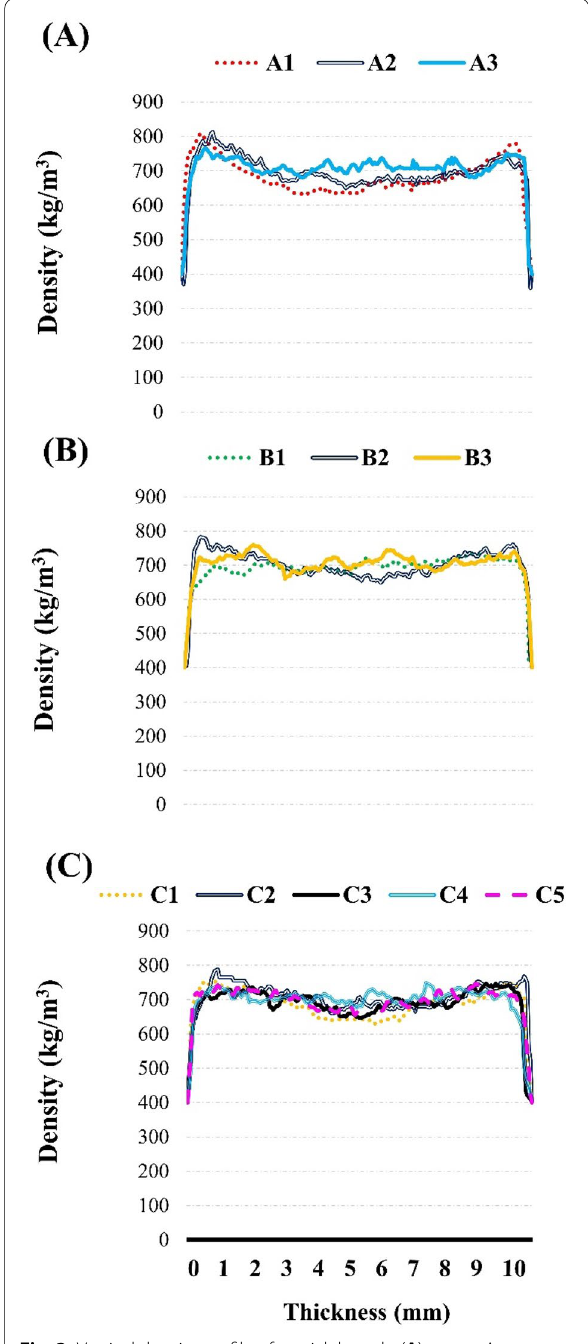
Fig. 3 Vertical density profile of particleboards, ( A ): group A (TOCS-based), ( B ): group B (wood-based), ( C ): group C (mix of TOCS and wood)